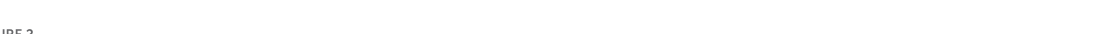
FIGURE2 Varied effects of MK-801 in context extinction, direct reactivation, and delayed reactivation conditions. Rats were trained to press a single lever for sucrose reward across 10 days (T1–T10) and then received a VR5 reactivation session (R) following MK-801 or Saline injection. (A) Lever pressing at test (T) was impaired in the context extinction condition, but not in the direct reactivation condition. In the context extinction condition previously MK-801 treated rats ( n = 12) showed significantly impaired lever pressing compared to Saline-treated control ( n = 13). No differences were observed during training or at reactivation. In the direct reactivation condition, there was no obvious difference between MK-801 ( n = 12) and saline ( n = 12) treated rats across any phase of the experiment. (B) Lever pressing at test was impaired in the delayed reactivation condition, but not in the context extinction condition. In the delayed reactivation condition previously MK-801 treated rats ( n = 7) showed significantly impaired discriminated lever pressing compared to Saline-treated controls ( n = 7). No differences were observed during training or at reactivation. In the context extinction condition, there was no obvious difference between MK-801 ( n = 8) and saline ( n = 8) treated rats across any phase of the experiment. (C) Lever pressing at test was impaired in the direct reactivation condition, but not in the delayed reactivation condition. In the direct reactivation condition previously MK-801 treated rats ( n = 8) showed significantly impaired discriminated lever pressing compared to Saline-treated control ( n = 7). No differences were observed during training or at reactivation. In the delayed reactivation condition, there was no obvious difference between MK-801 ( n = 8) and saline ( n = 8) treated rats across any phase of the experiment. Data are presented as mean ±